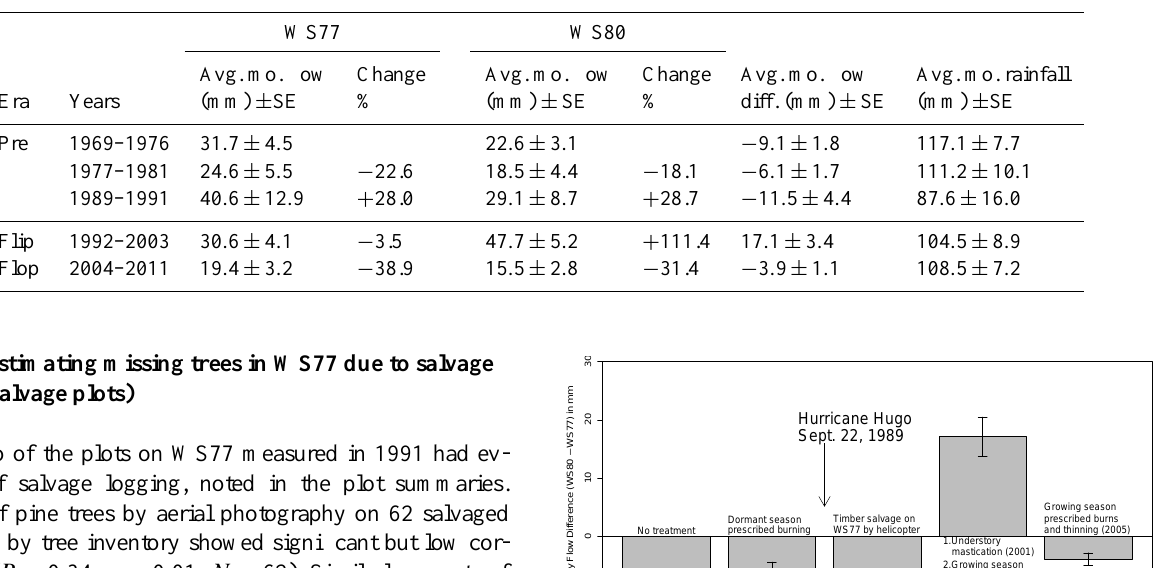
Fig. 5. Monthly rainfall totals in the two study watersheds grouped Table 1. Mean monthly flows, change in flows, and rainfall by era for WS77 and WS80. Percent change in flow by era were calculated with respect to flow during the calibration period (pre era: 1969–1976).